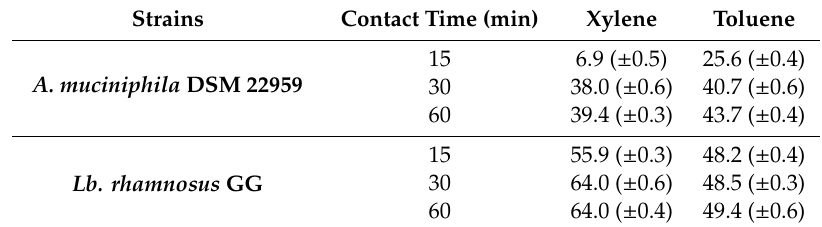
Table 2. Adhesion of A. muciniphila DSM 22959 and Lb. rhamnosus GG to hydrocarbons (expressed